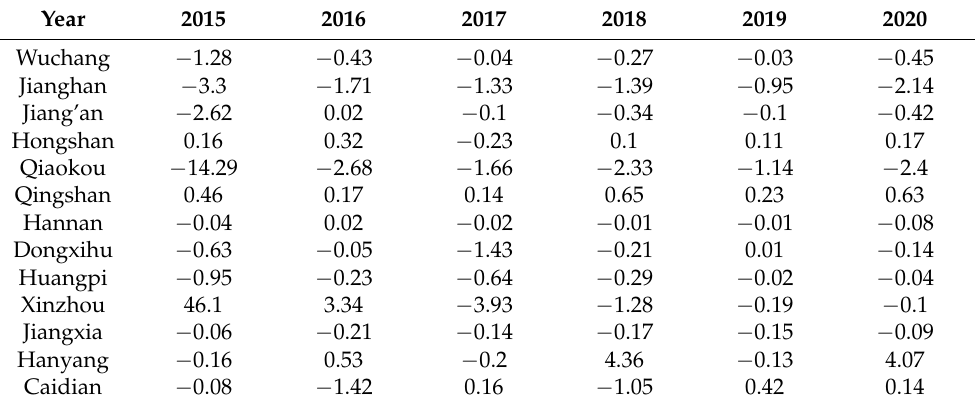
Table 5. Decoupling index of urban economy and ecological environment in Wuhan city from